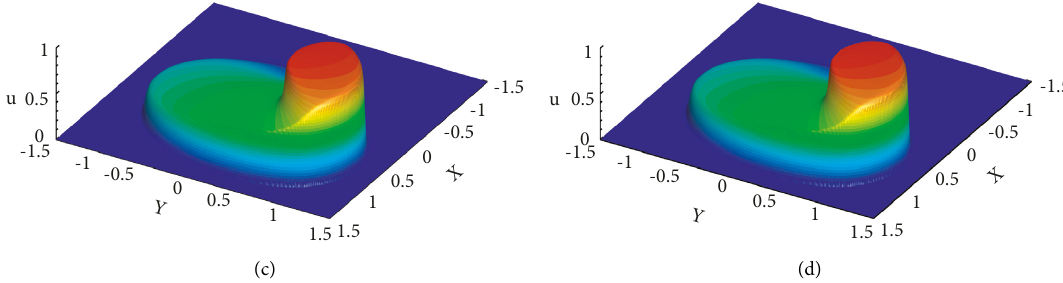
Figure 10: Example 8. 2D PME. T � 0.5. CRUS-WENO scheme (a, c); WENO-JS scheme (b, d). 200 × 200 grid points.